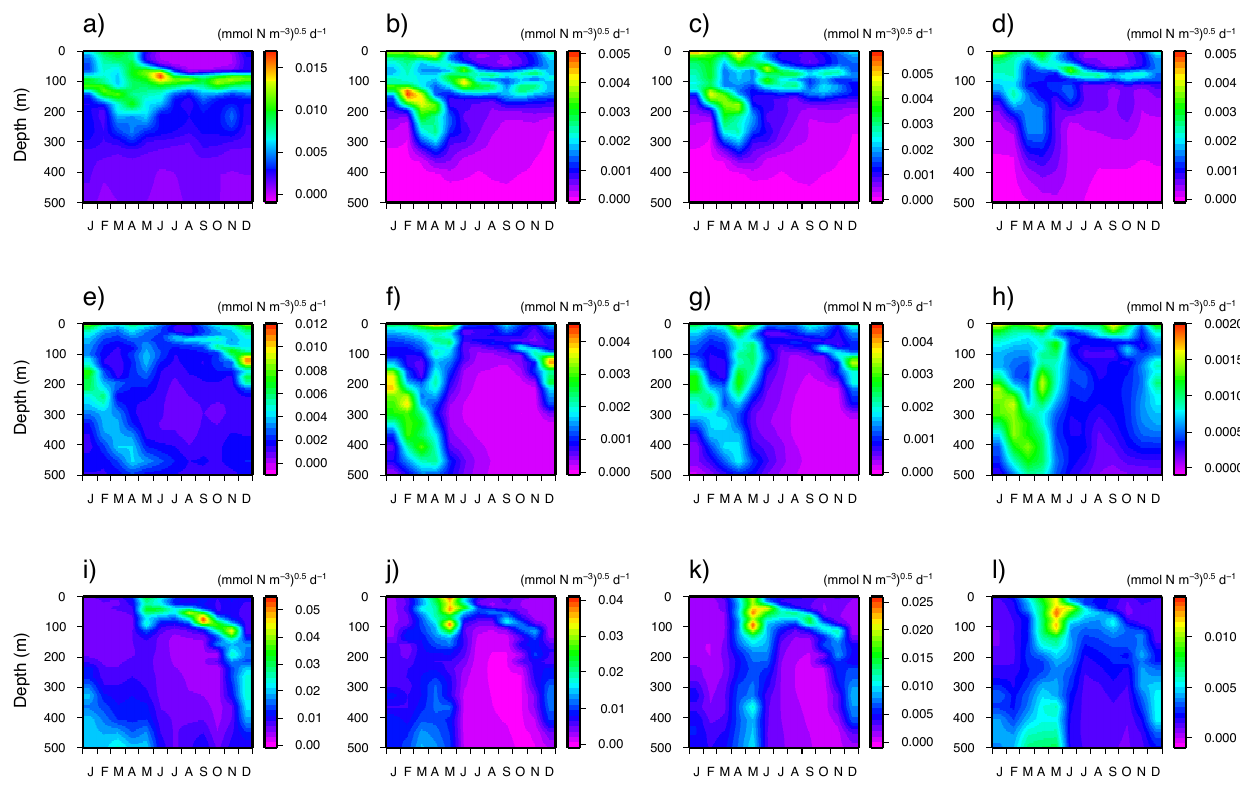
√ N ), (b) phytoplankton